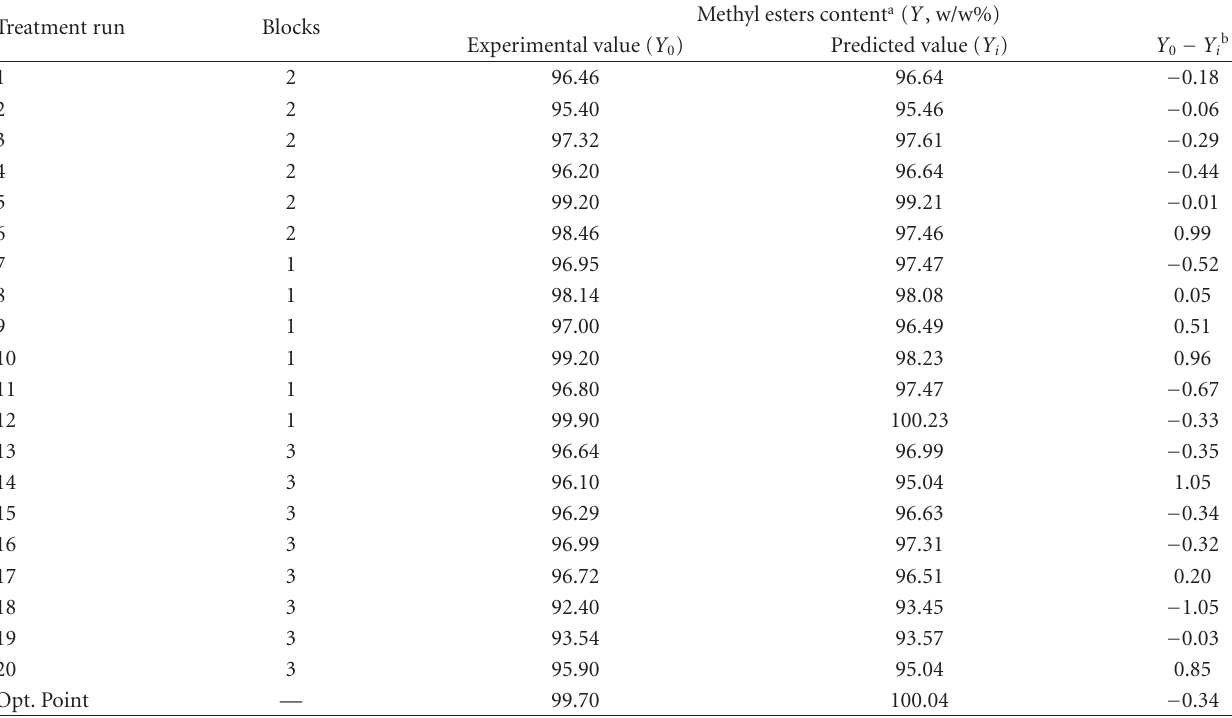
Table 2: Trial and predicted values for response variables of the reduced model.